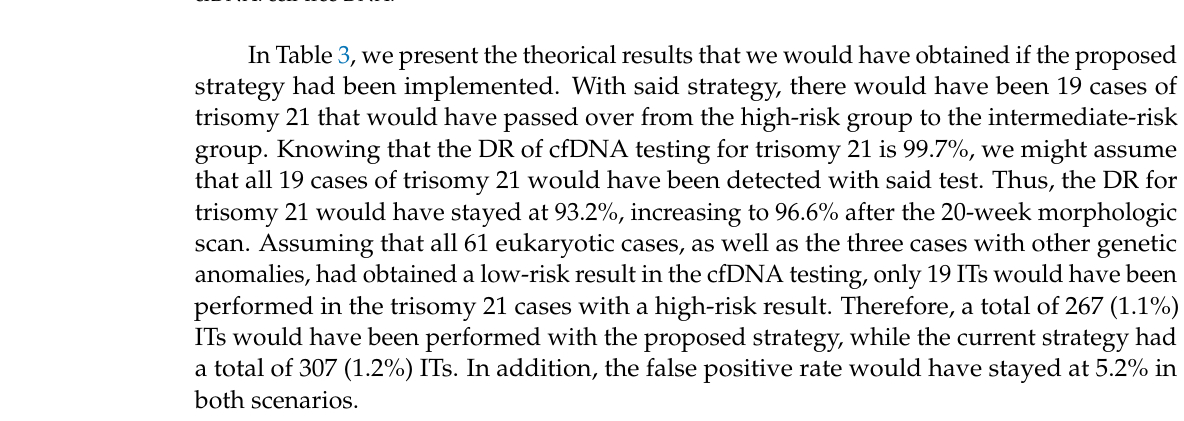
Table 3. Comparative performance of both